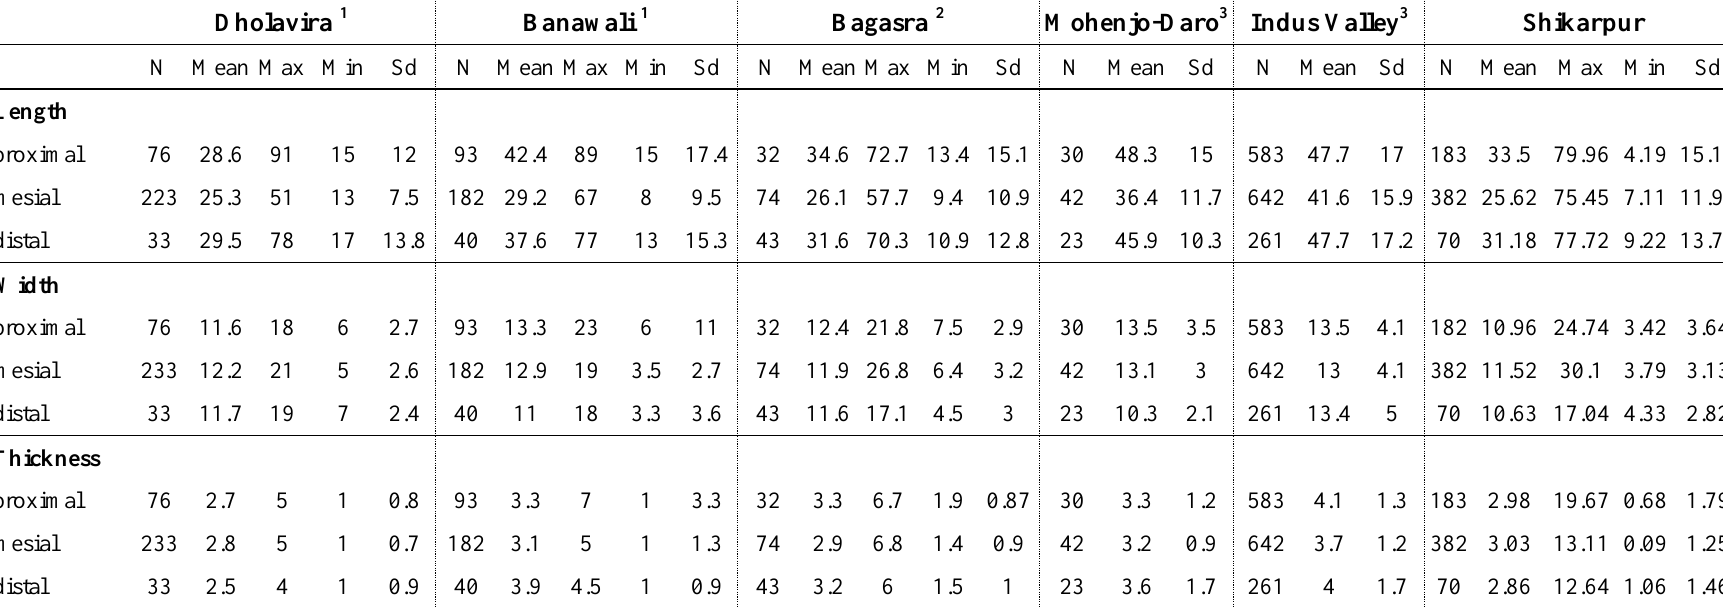
Table 2: Metric comparison of Rohri chert blades (all sizes are in mm) Dholavira 1 Banawali 1 Bagasra 2 Mohenjo-Daro 3 Indus Valley 3